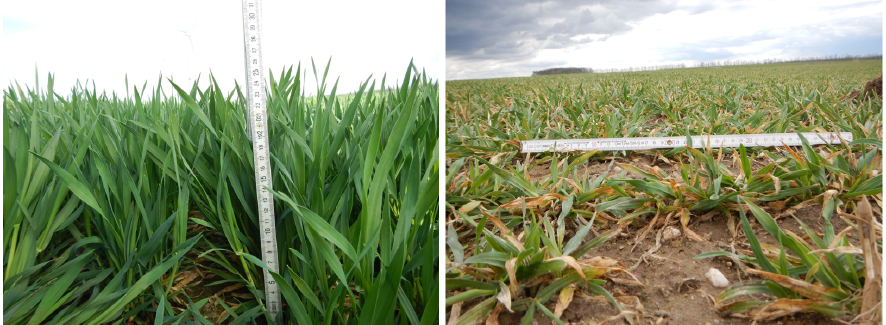
Figure 11. Barley field “C” at 4th of April 2017 ( left ) and barley field “H” at 5th of April 2018 ( right ).